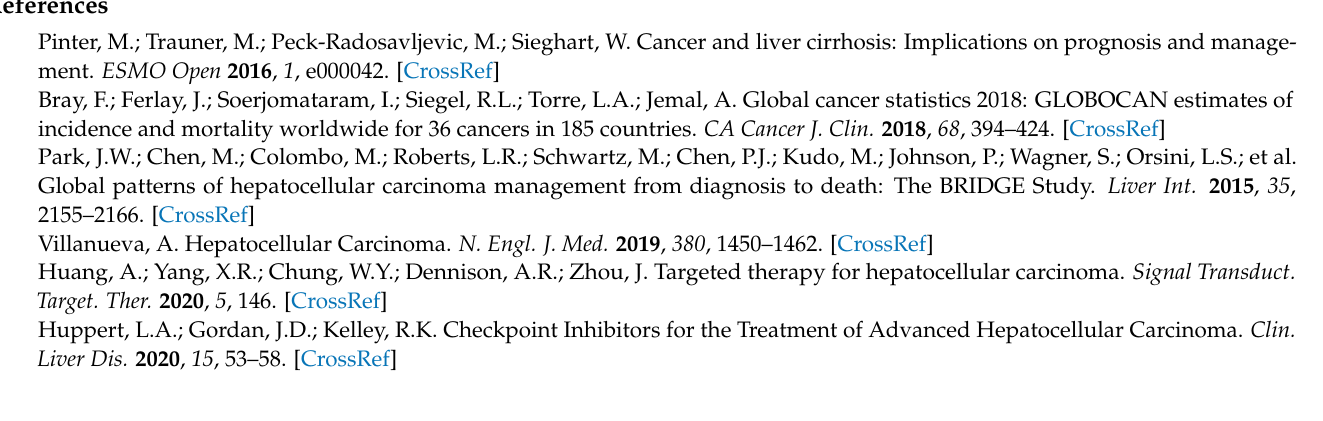
HCC model, Table S1: Fluorochrome-labelled-antibodies used for FACS, Table S2: Probes used for murine RNA quantification via qPCR, Table S3: Probes used for human RNA quantification via